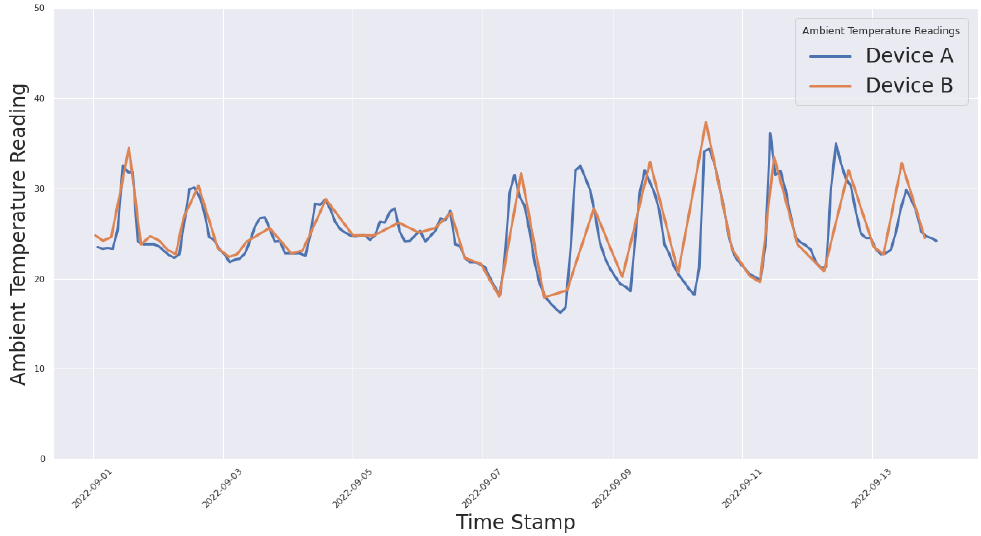
Figure 17. Sample visual of the recorded ambient temperature from two outdoor nodes in the same